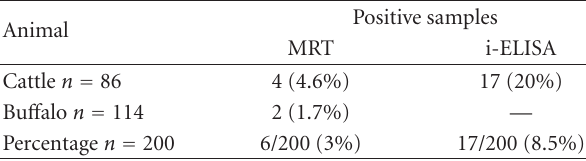
Table 1: Prevalence of bovine brucellosis in milk samples using MRT and i-ELISA in District Quetta, Balochistan, Pakistan.